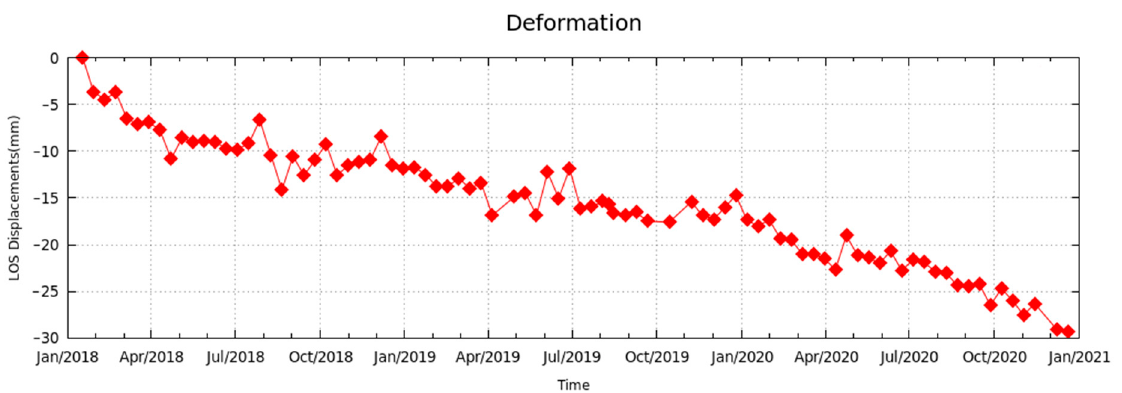
Figure 11. Deformation of point P1 during the monitoring period.